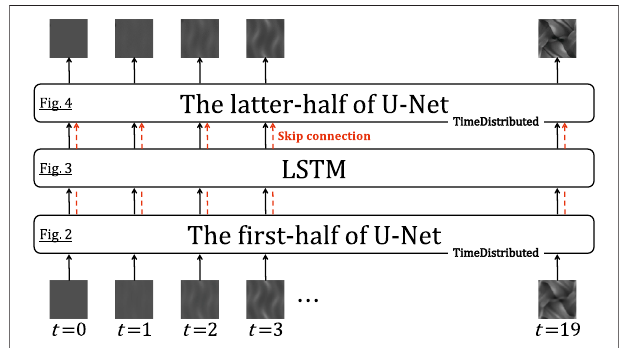
FIGURE 1 | Schematic picture of the architecture of the generator in this research. The generator in the original pix2pix network is a U-shaped network (U-Net). In this research, the LSTM layer is inserted into the middle of U-Net. Theskipconnectionsfromthe fi rst-halfofU-Nettothelatter-halfoverthe LSTM layer are implemented.